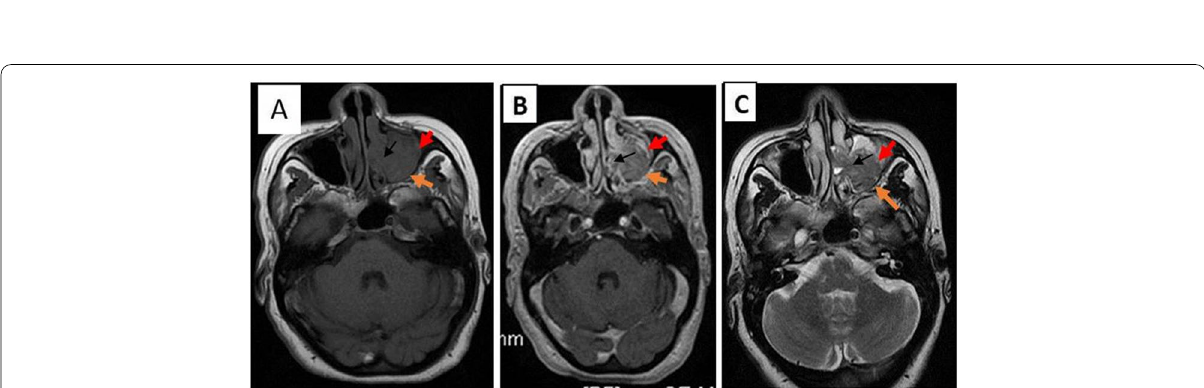
Fig. 5 Axial T1W ( A ), Fat-Sat contrast-enhanced T1W ( B ), and T2W ( C ) MR images showing a tissue mass (red arrow) of the left MS extending to the homolateral nasal cavity involving medial (black arrow) and posterior (orange arrow) walls of MS, hypointense in T1W, with an intermediate heterogeneous signal and moderate and heterogeneous enhancement